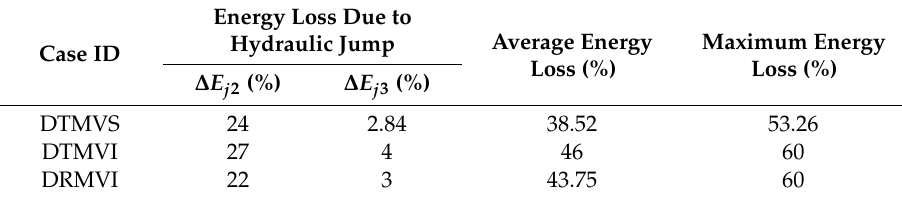
Figure 11. Experimental and computed results comparison: ( a ) OVS and OVI, ( b ) DVS and DVI, and ( c ) DTMVS, DTMVI, and DRMVI. Table 3. Summary of energy dissipation of HDS.